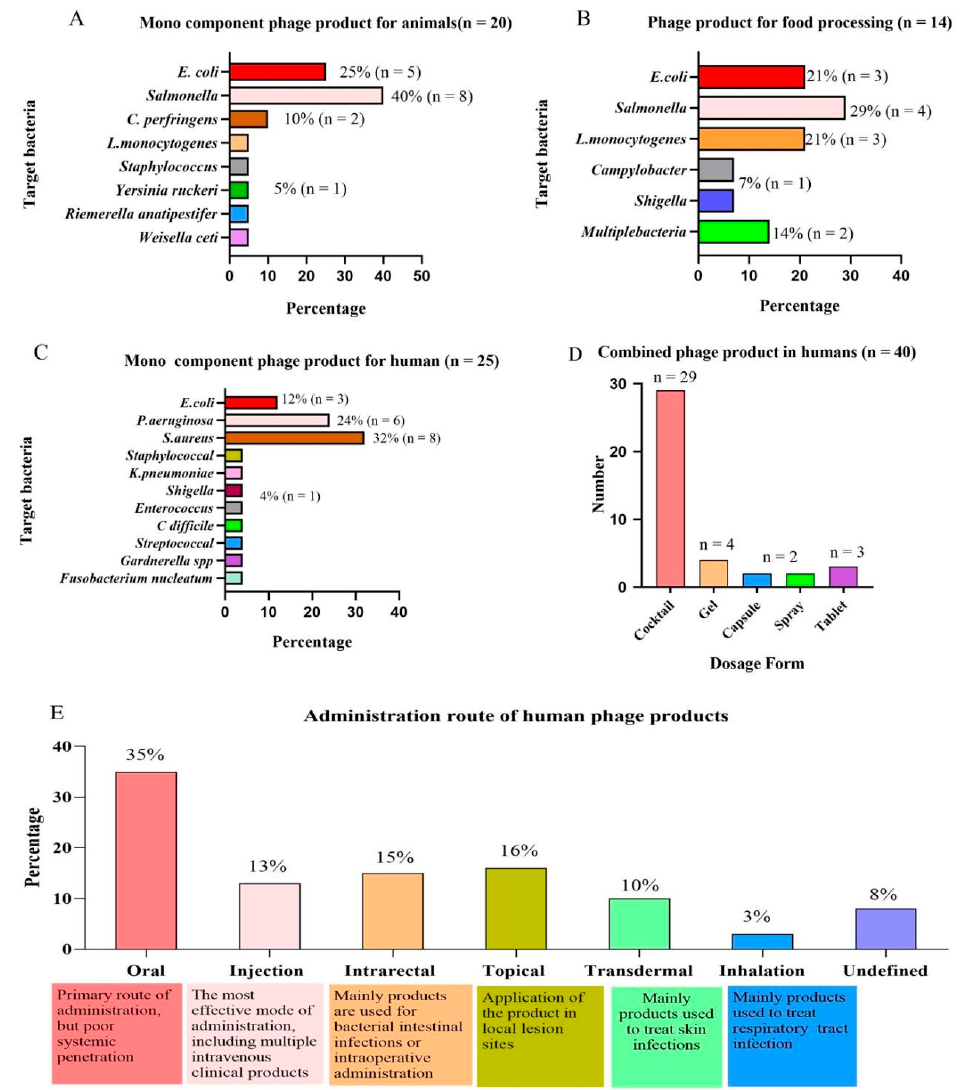
Figure 2. Analysis of phage products from the perspective of the “one health” approach. ( A ) Targeted bacteria for mono-component phage products in animals. ( B ) Targeted bacteria for phage products in food processing. ( C ) Targeted bacteria for mono-component phage products in humans. ( D ) Main dosage forms of phage products in human therapy. ( E ) Main routes of administration for human phage